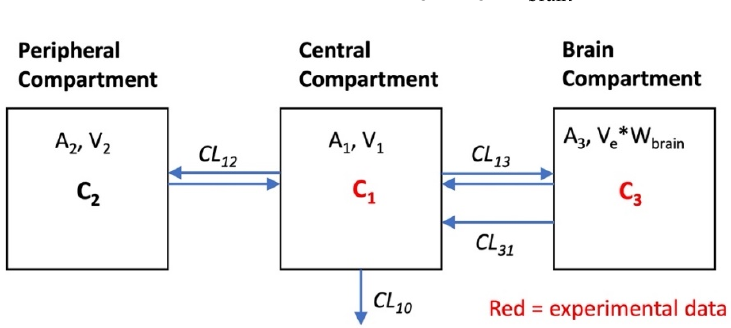
Figure 4. Schematic of a three-compartment semi-physiologic model for the pharmacokinetic study. Parameter definitions are given in the methods above. A 1 , V 1 , C 1 are the amount, the volume, and the concentration in the central compartment 1, analogous in the peripheral compartment 2. A 3 is the amount in brain tissue; V e the volume fraction of brain ISF (mL/g); W brain is brain weight; and C 3 the concentration in brain tissue after correction for the intravascular content. Reprinted with permission from Reference [19]. Copyright 2022, Springer